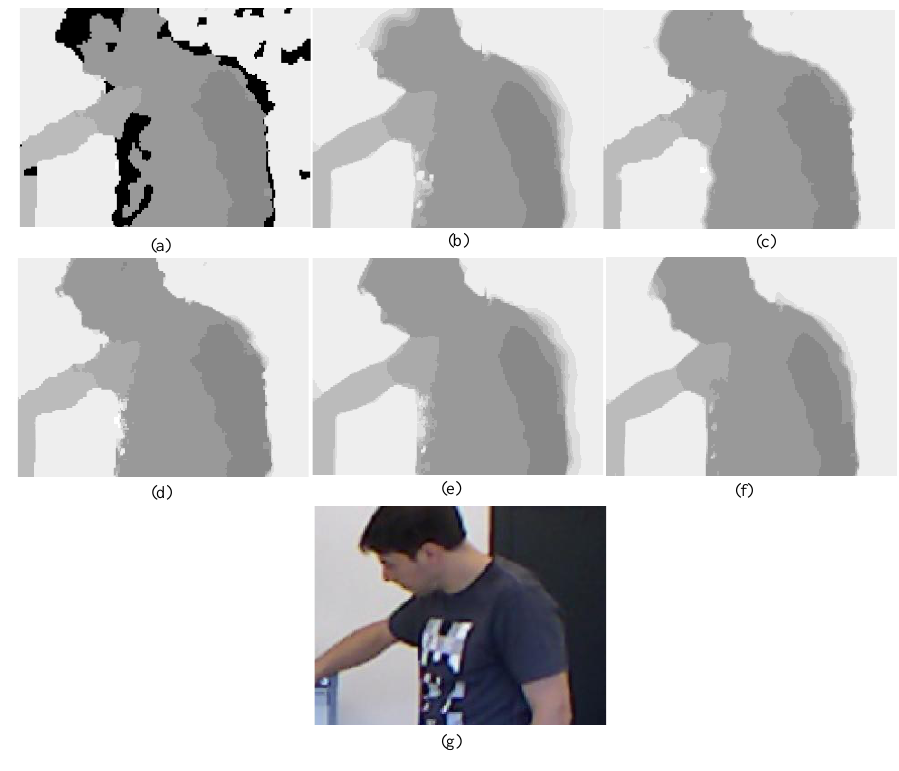
Figure 13. Zoomed-in results for Figure 11: ( a ) Original; ( b ) JBF; ( c ) FMI; ( d ) GFMI; ( e ) GFMIGF; ( f ) Proposed method; ( g ) Color